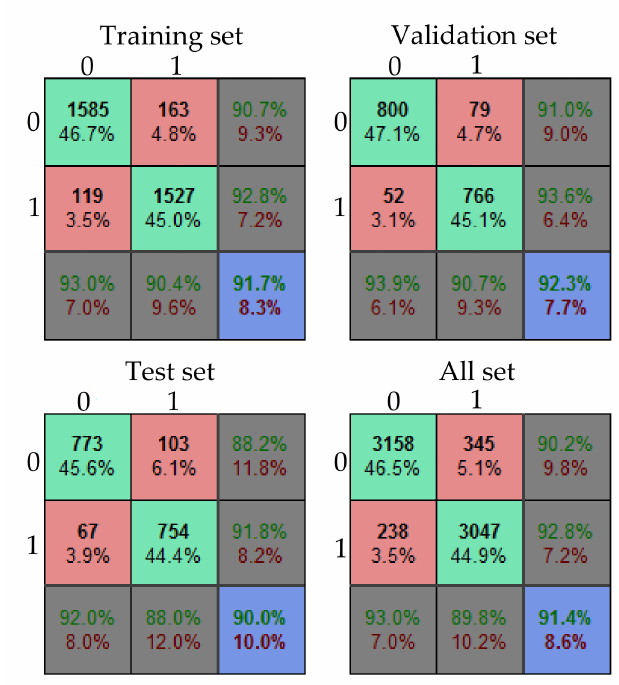
Figure 9. Training results using the BP neural-network model with 150 neurons in the hidden